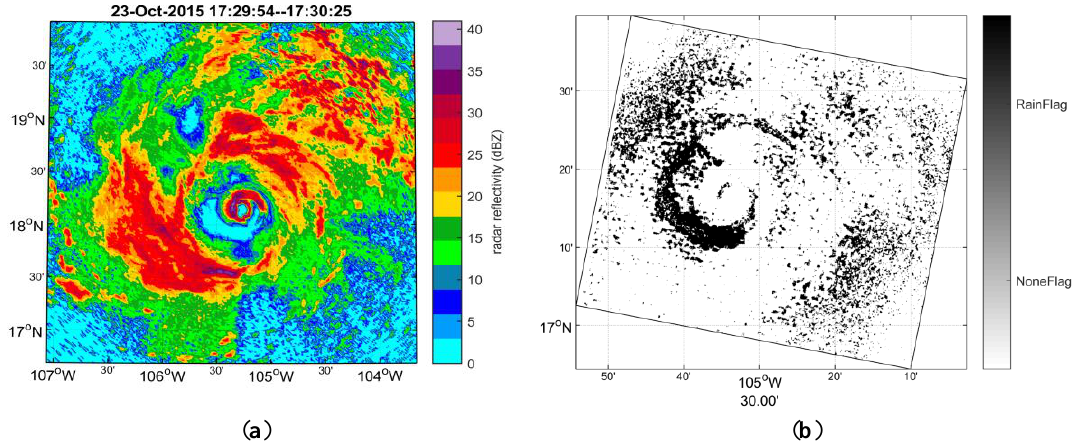
Figure 7. Radar reflectivity measured on board NOAA 43 flight at 05:30PM 23 October 2015: ( a , b ) rain flag of Hurricane Patricia at 12:45 UTC on 23 October 2015 as retrieved from SAR. Both figures show a heavy precipitation pattern in the shape of the number “6” in Hurricane Patricia. The observed spatial pattern in ( a ) is consistent with that of the rain index from SAR in figure ( b ).